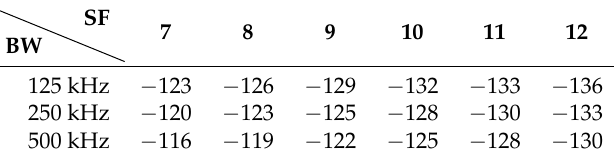
Table 1. Semtech SX1276 LoRa receiver sensitivity in dBm at different bandwidths and spreading factors, taken from [19].